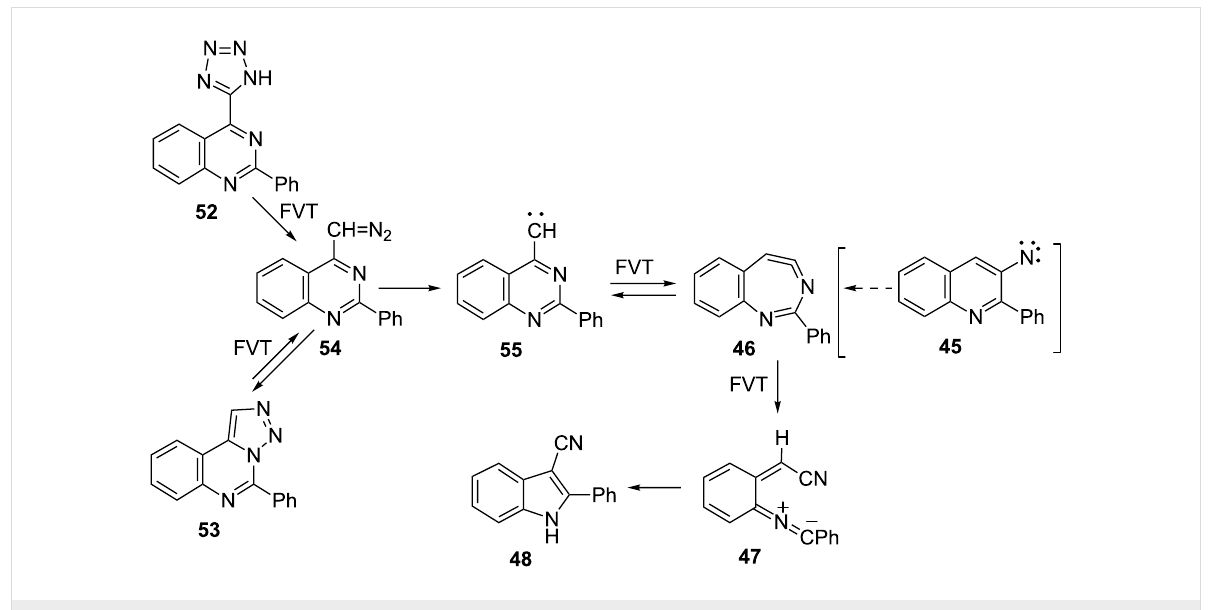
Scheme 13: FVT of 2-phenyl-4-quinazolinylcarbene precursors.